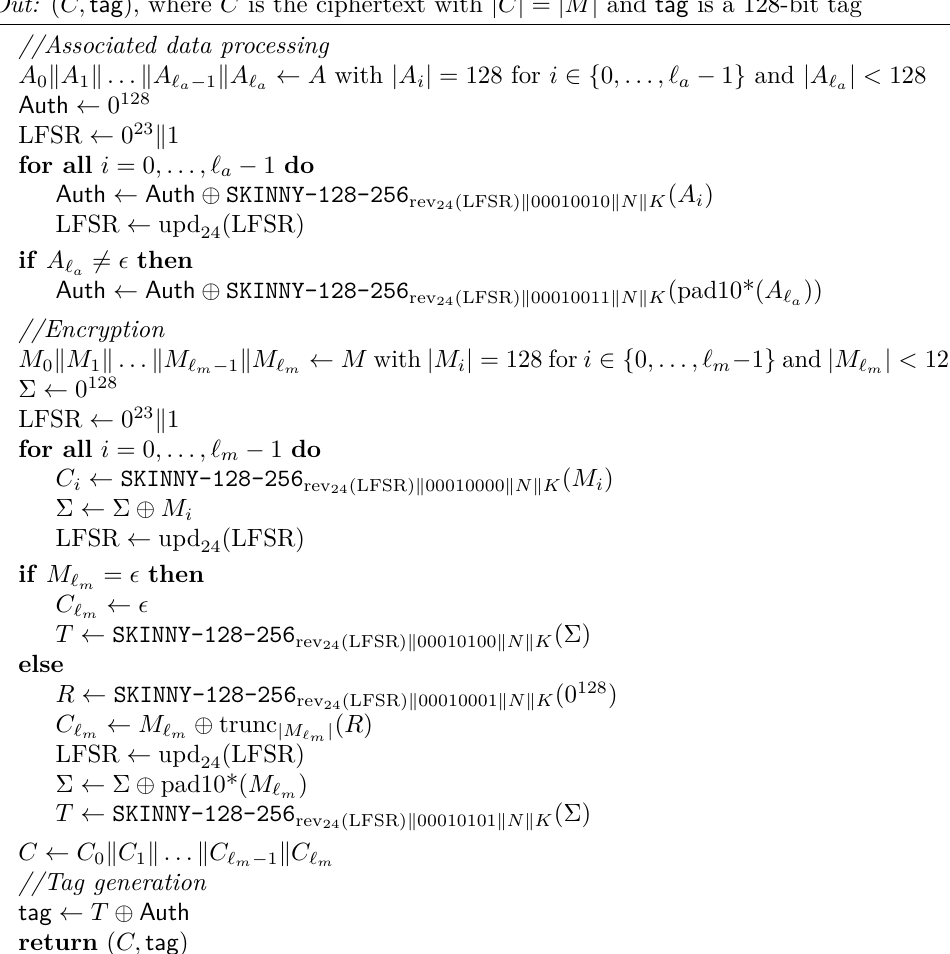
Algorithm 11 The authenticated encryption algorithm SKINNY - AEAD - M5 - Enc ( K, N, A, M